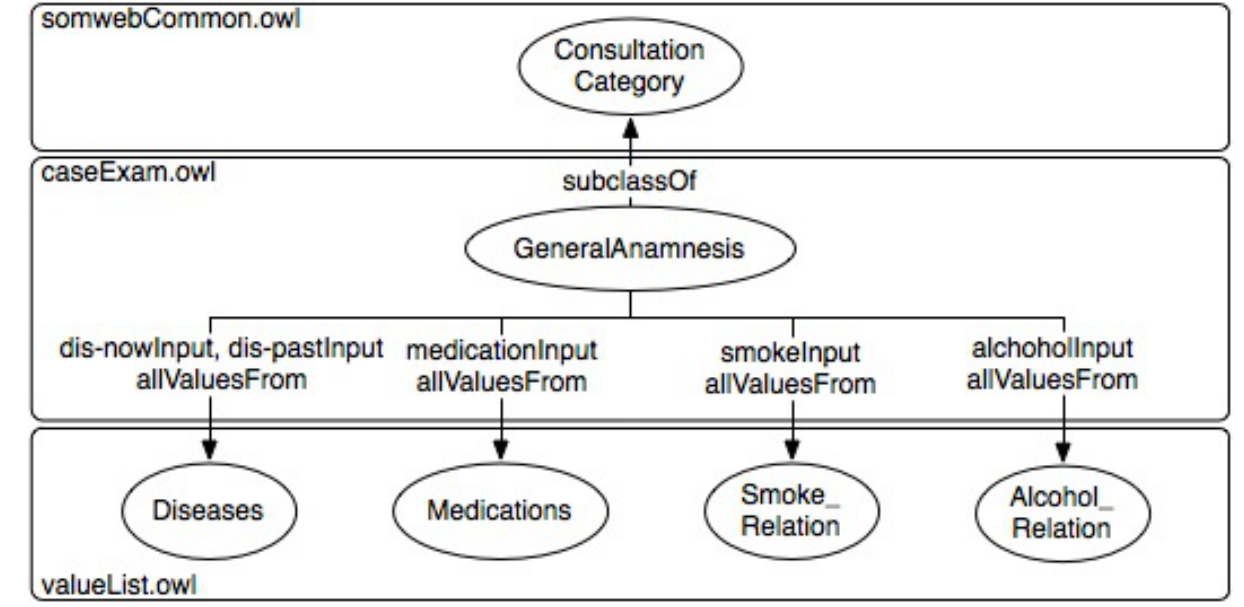
Figure 7. An example of a ConsultationCategory, GeneralAnamnesis, showing how OWL allValuesFrom restrictions are used to connect its inputs (properties) to classes of the value list